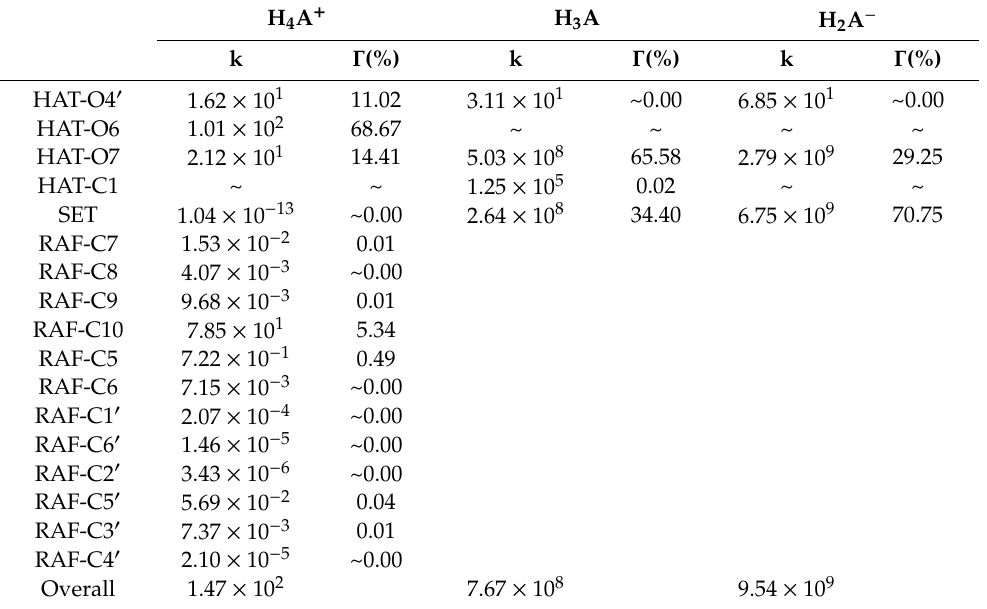
Table 3. Rate constants (M − 1 s − 1 ) and branching ratios ( Γ ) computed at the M062x level of theory at 298.15 K.